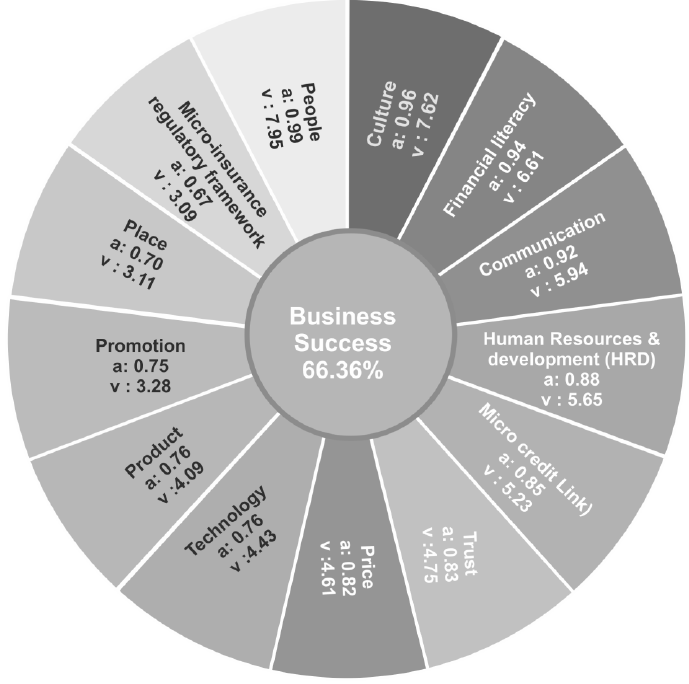
Figure 2. The applied